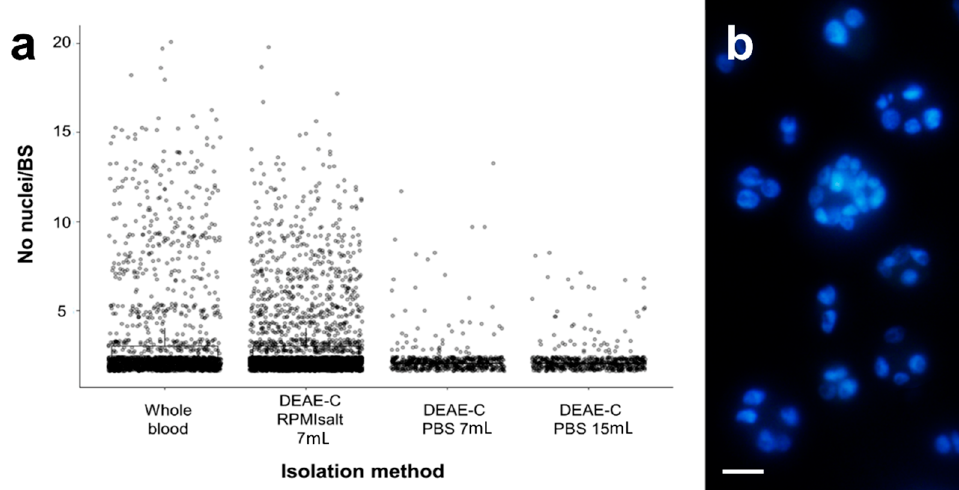
Figure 2. ( a ) Cellularity of S. molnari BS prior to isolation (in whole blood) and after isolation, using different methods (DEAE-C) and elution buffers. The corresponding numerical data is presented in Table 1. Grey circles represent jittered raw data of nuclei per BS counted in DAPI-stained smears. The total number of stages in each column differs depending on the number of replicates/fish (one replicate = 3 smears = 600 counted BS; Whole blood = 1800 stages (3 fish); DEAE-C RPMI salt 7 mL = 3000 stages (6 fish); DEAE-C PBS 7 mL and 15 mL = 600 stages (3 fish)). ( b ) DEAE-C isolated S. molnari BS, DAPI-stained to determine parasite cellularity. Image shows stages composed of 2–16 cells; size bar—5 µm. Table 1. Cellularity of S. molnari blood stages in whole blood and after cell separation using different methods and elution buffers. The number of cells is equivalent to the number of nuclei, which was counted in 200 cells, after DAPI staining; F10–F12 represent samples from three individual fish that harbored parasite populations variable in composition and cellularity. Values in the table represent the percentage of the relevant stage in the whole parasite population.